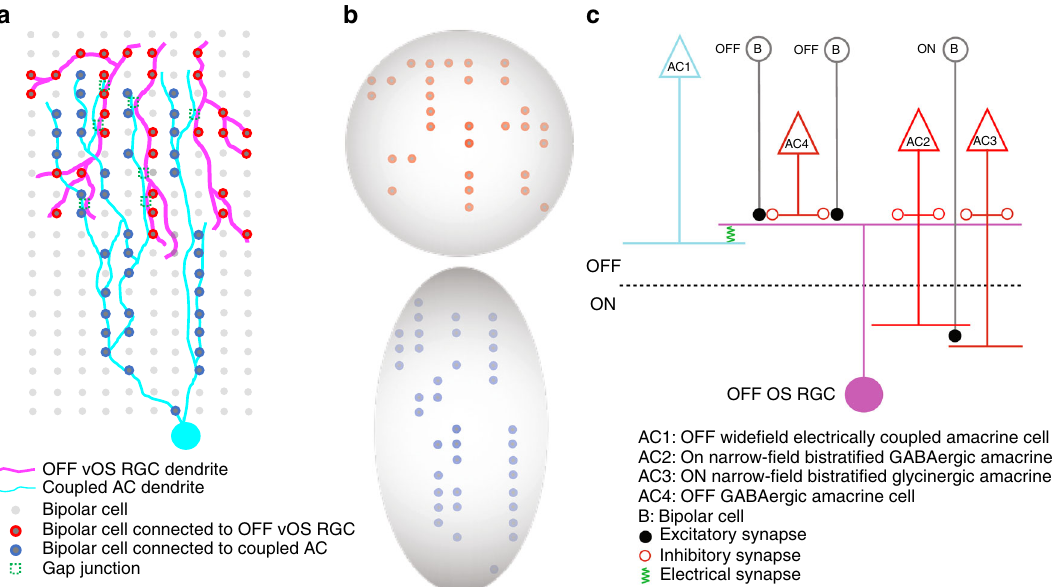
Fig. 9 Schematic OFF OS RGC circuit model. a Top projection view of the OFF vOS RGC circuit. Dendrites of an OFF OS RGCs (magenta) are electrically coupled to an asymmetric amacrine cell (cyan). b Excitatory receptive fi elds for OFF vOS RGCs and coupled amacrine cells. The excitatory bipolar cell input to OFF vOS RGCs is predicted to be symmetric based on the cell ’ s dendrites, whereas the excitatory input to the coupled cells is predicted to be asymmetric (Fig. 2). c Schematic model of neural circuit underlying the OS computation in OFF OS